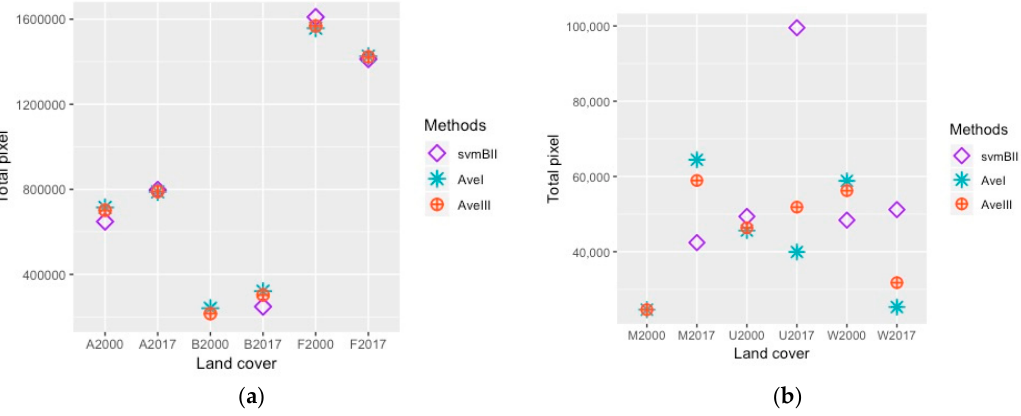
Figure 6. Distribution of each land cover type’s total pixels at 2000 and 2017 with three di ff erent calculations. svmBII means land cover pixel came from dataset B and SVM algorithm, AveI means land cover pixel came from the average of classification method I, and AveIII means pixel came fromteh average of classification method I and II. ( a ) contains Agriculture (A), Bareland (B), and Forest (F); ( b ) contains Mine sites (M), Urban (U), and Water